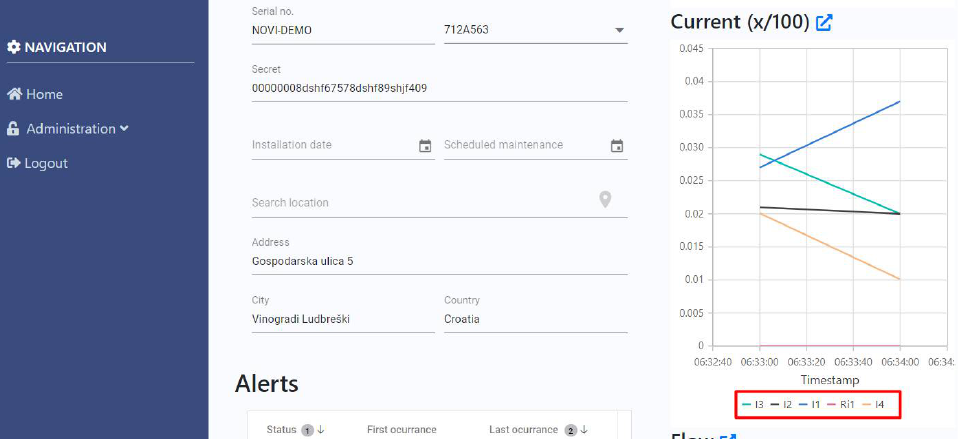
Figure 12. Cloud application